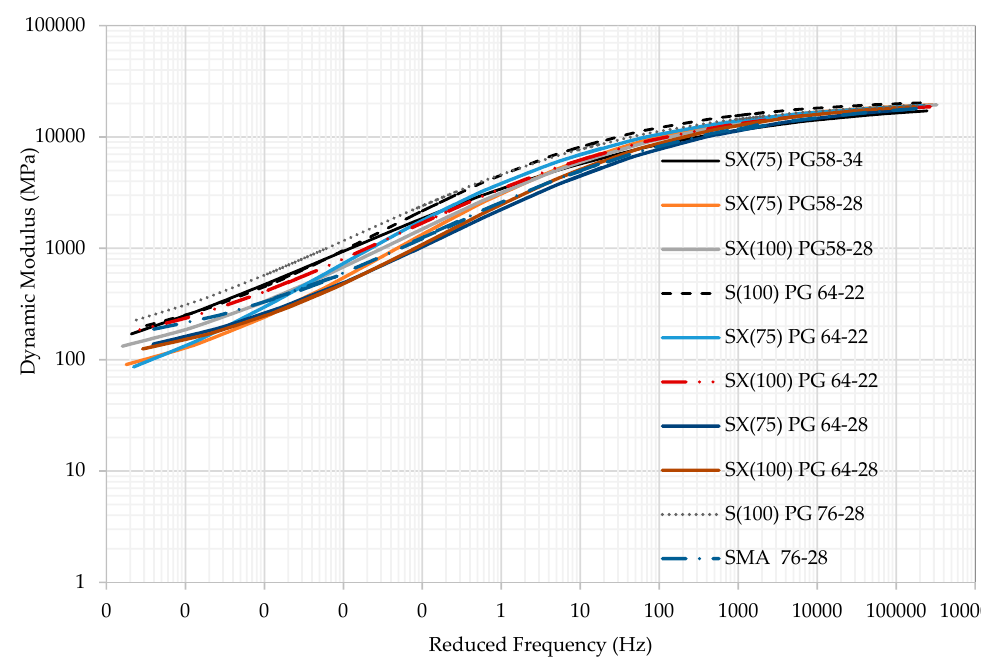
Figure 2. Groupwise comparison in a log–log graph.